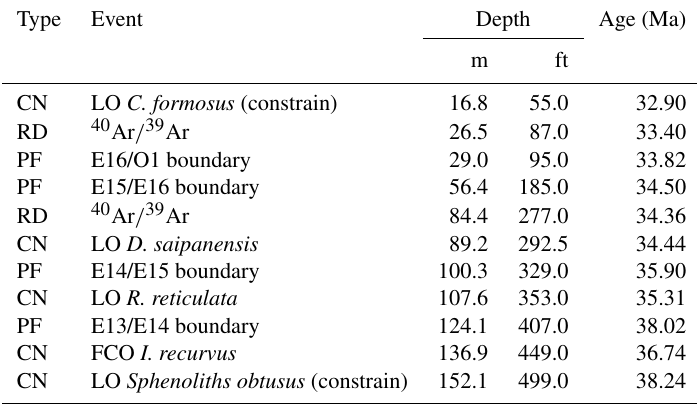
Table 1. List of bioevents, biohorizons, and calibrated ages, updated to the timescale of Westerhold et al. (2014). Legend: CN – calcare- ous nannofossils (this study); PF – planktonic foraminifera (Fluegeman et al., 2009); RD – radiometric dating (Obradovich et al., 1993; Obradovich and Dockery III, 1996).